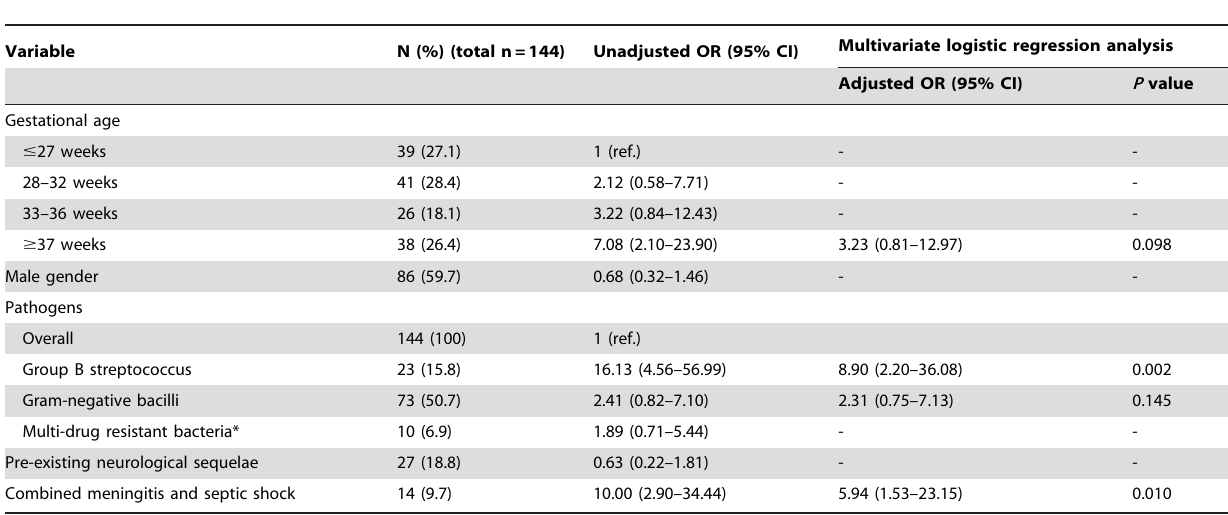
Table 3. Risk factors for neurological complications in neonatal bacteremia with meningitis or septic shock.